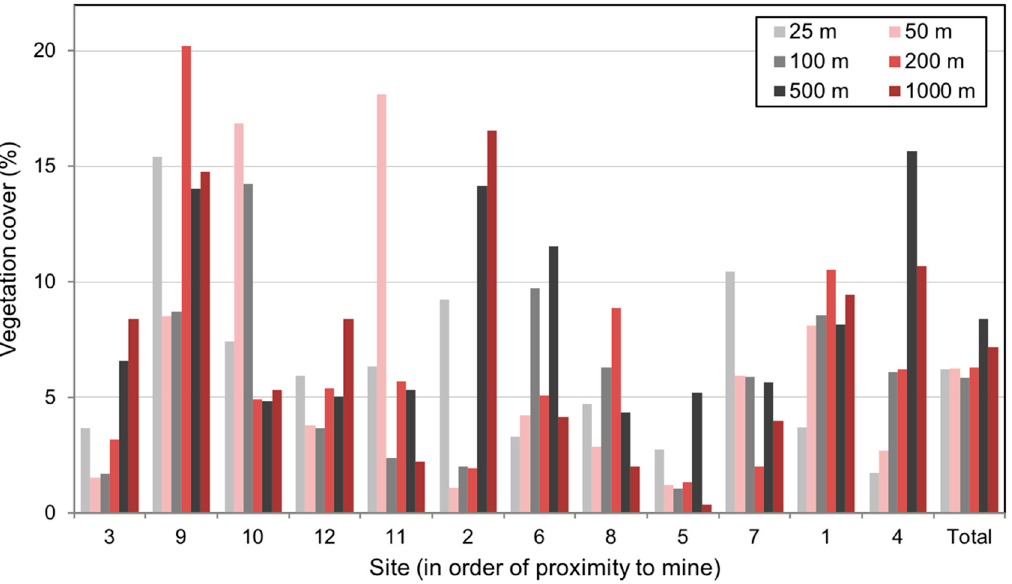
Figure 2. Vegetation cover at 12 experimental transects in Khanbogd soum , at increasing distance (m) from a given water source. Sites are ordered by proximity to mine (site 3 is closest and site 4 is furthest).